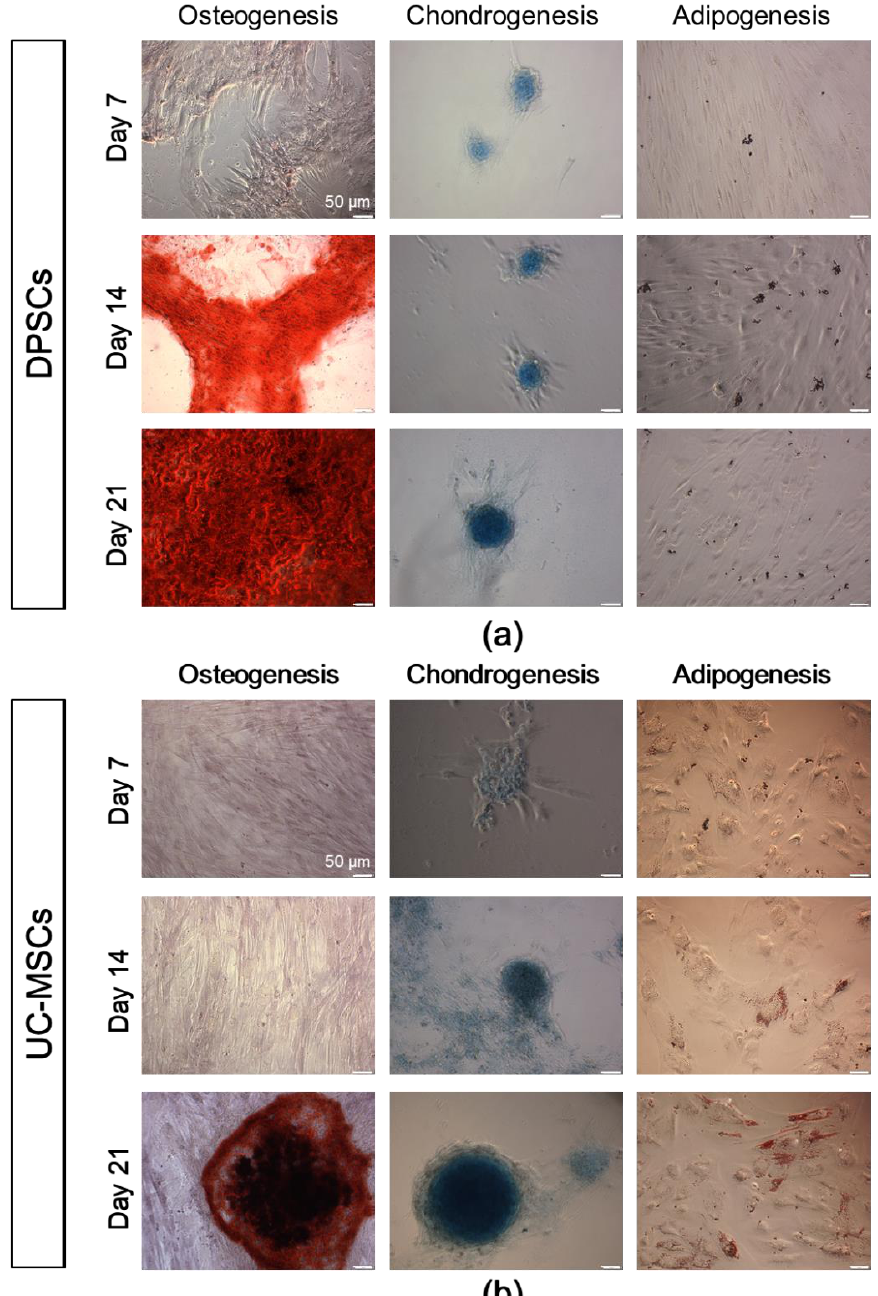
Figure4. Tri-lineagedi ff erentiationpotentialofDPSCsandUC-MSCsinanin vitroculturedemonstrated Figure 4. Tri-lineage differentiation potential of DPSCs and UC-MSCs in an in vitro culture by histochemical staining. ( a ) Representative images of DPSCs di ff erentiated into osteoblasts, demonstrated by histochemical staining. ( a ) Representative images of DPSCs differentiated into chondroblasts and adipocytes. ( b ) Representative images of UC-MSCs di ff erentiated into osteoblasts, osteoblasts, chondroblasts and adipocytes. ( b ) Representative images of UC-MSCs differentiated into chondroblasts, and adipocytes. DPSCs and UC-MSCs were cultured in a StemPro osteogenesis di ff erentiation kit, StemPro chondrogenesis di ff erentiation kit, or StemPro adipogenesis di ff erentiation kit. On days 7, 14, and 21 of di ff erentiation, DPSCs and UC-MSCs were fixed with paraformaldehyde and stained with Alizarin Red S (red staining of calcium phosphate deposits that are a characteristic of osteogenic di ff erentiation), Alcian Blue (blue staining of sulphated proteoglycans that are a characteristic of chondrogenic di ff erentiation) or Oil Red O (brownish red oil droplets that are a characteristic of adipogenic di ff erentiation). Scale bars: 50 µ